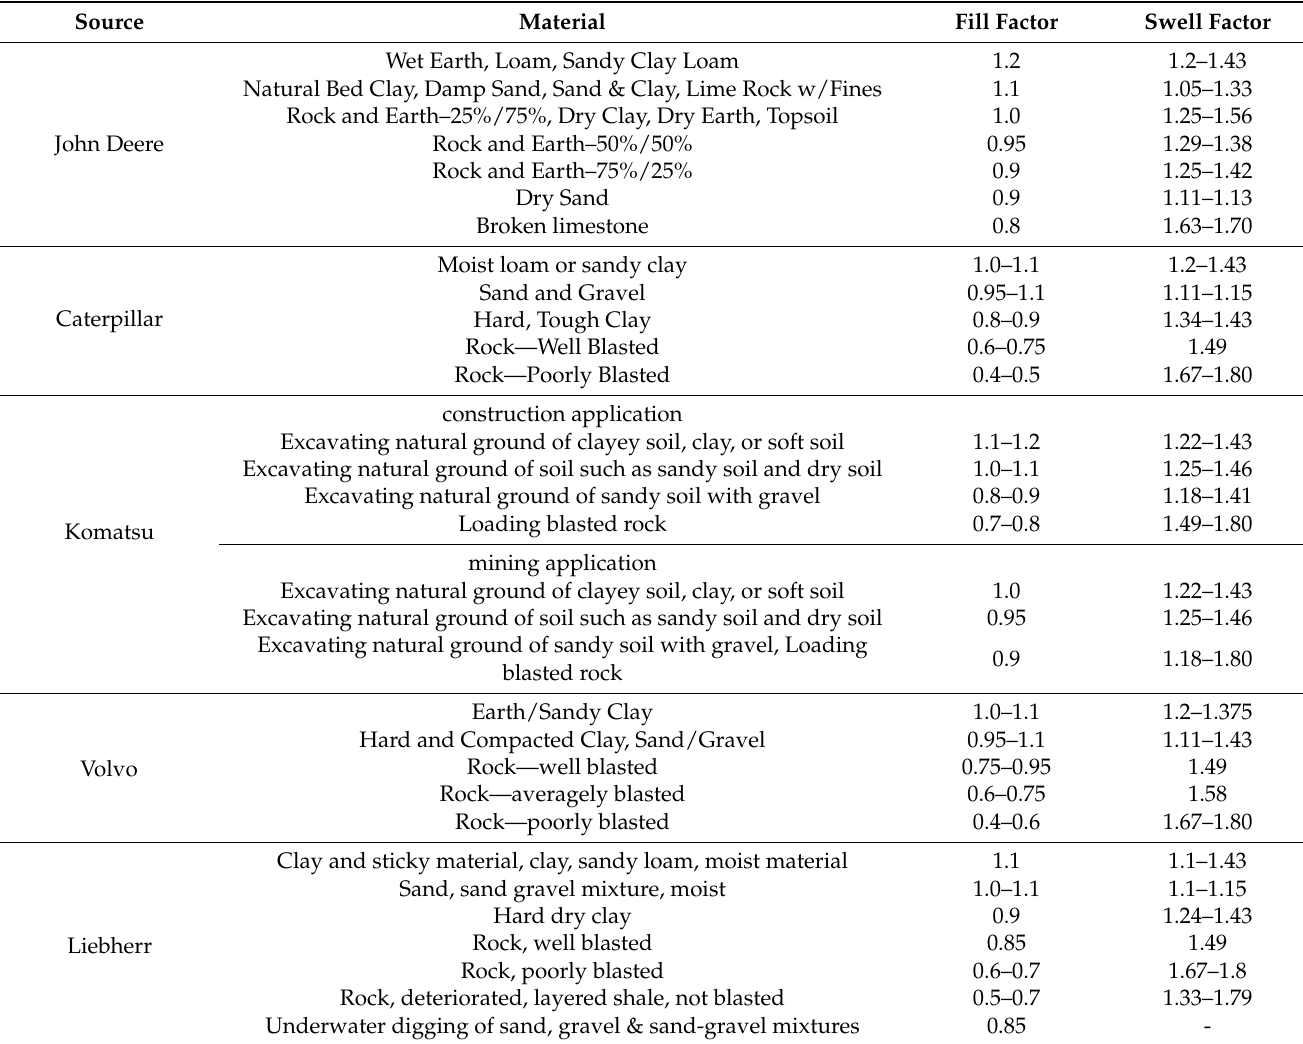
Table 2. Excavator bucket fill factor from manufacturer